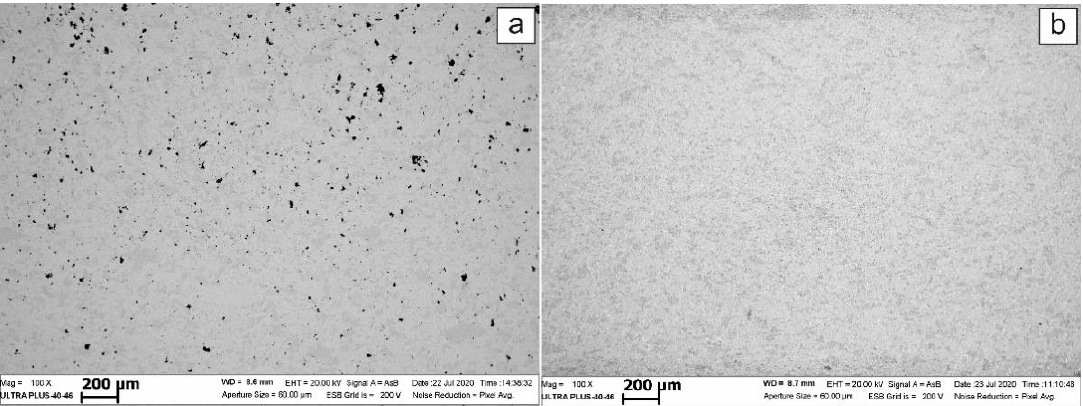
Figure 5. Microstructure of materials SPS-consolidated at 800 °C ( a ) and 1000 °C ( b ). Backscattered electrons images.